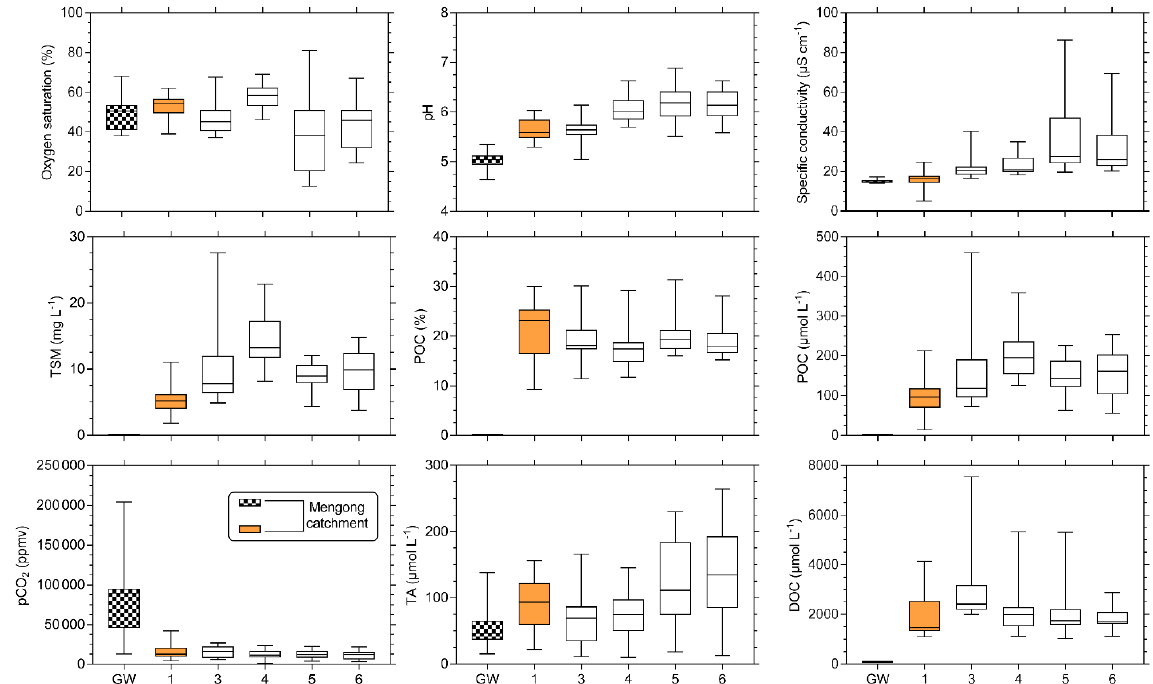
Figure 6. Spatial variations in carbon parameters ( p CO 2 , TA, DOC, POC) and ancillary parameters (oxygen saturation, pH, specific conduc- tivity, TSM) across non-flooded forest groundwater (GW) and stream orders 1, 3, 4, 5 and 6 in the Nyong watershed. Note that the hashed and orange boxplots are for non-flooded forest groundwater and first-order streams, respectively. The boxplots represent the minimum, the first quartile, the median, the third quartile and the